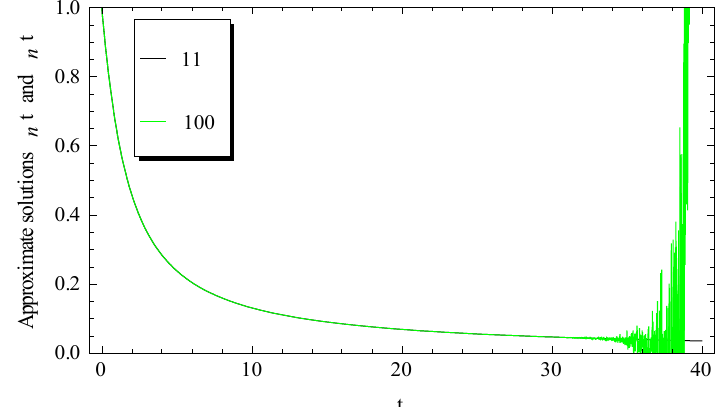
Figure 6. Comparison between the Adomian approximate solutions and power series solution at λ = 1 and q = 2.